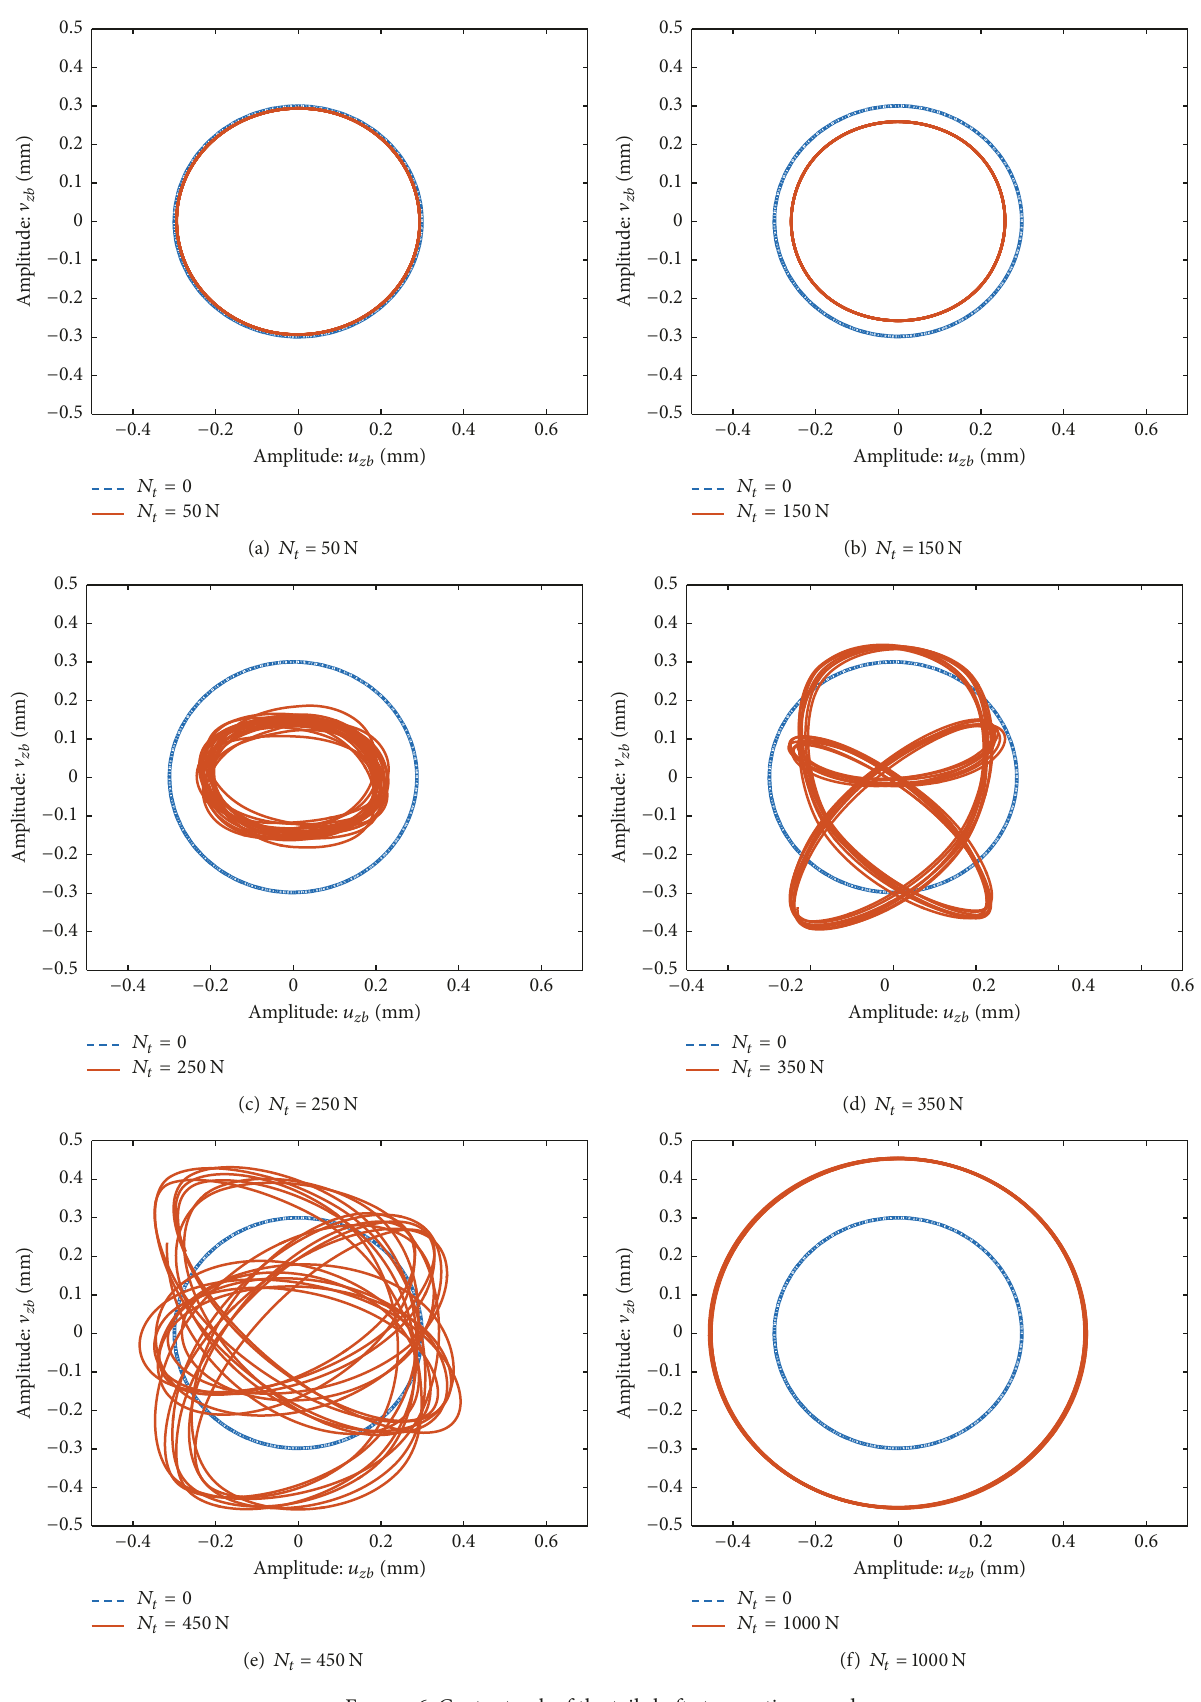
Figure 6: Center track of the tail shaft at operating